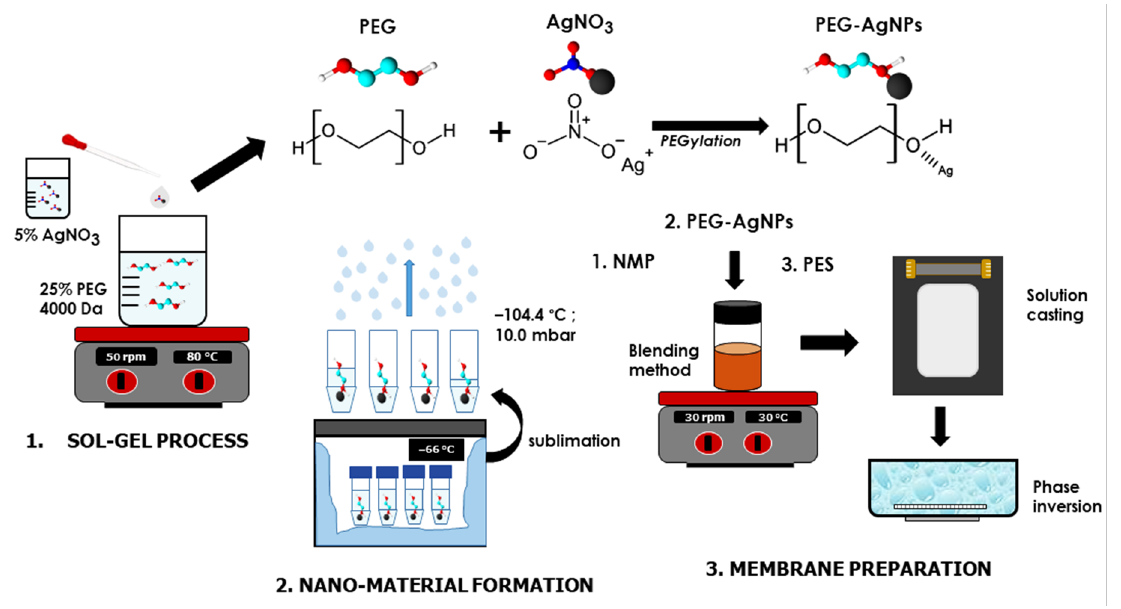
Figure 1. Comprehensive schematic diagram of additive and membrane preparation.